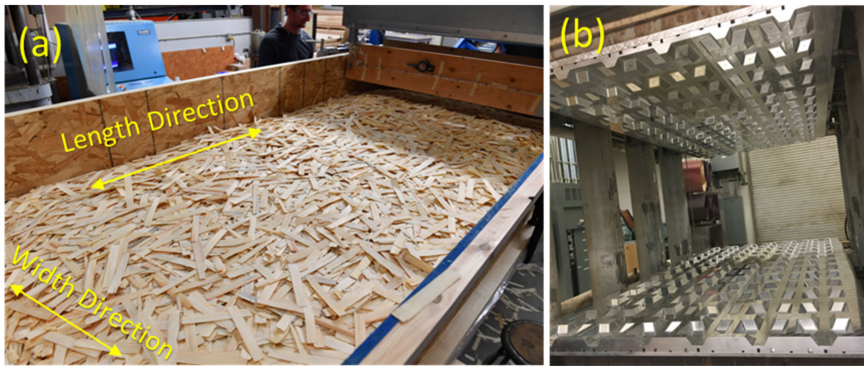
Figure 3. ( a ) Wood-strand mat ( preform ), and ( b ) Aluminum matched-die mold.